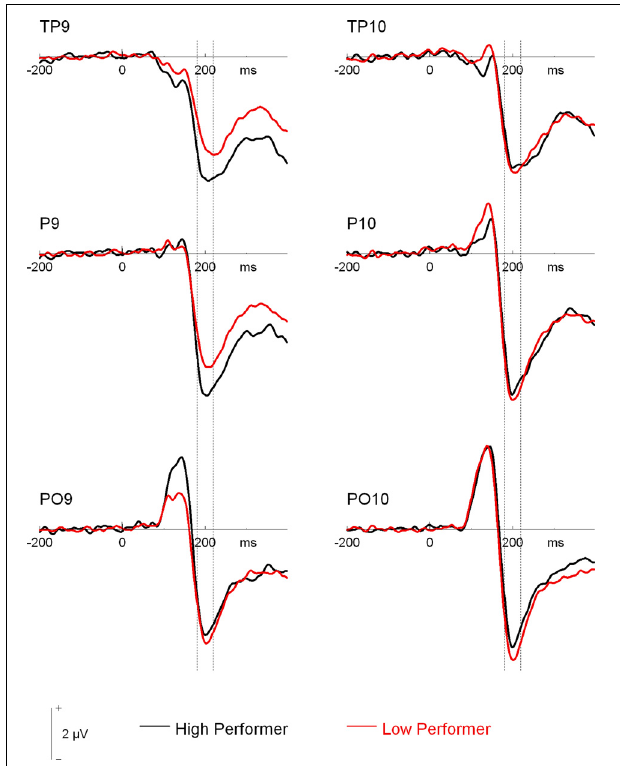
FIGURE 4 | Grand mean waveforms of high- and low-performing participants from the learning phases of the recognition memory experiment. Dashed lines depict the 180–220ms (N170) time